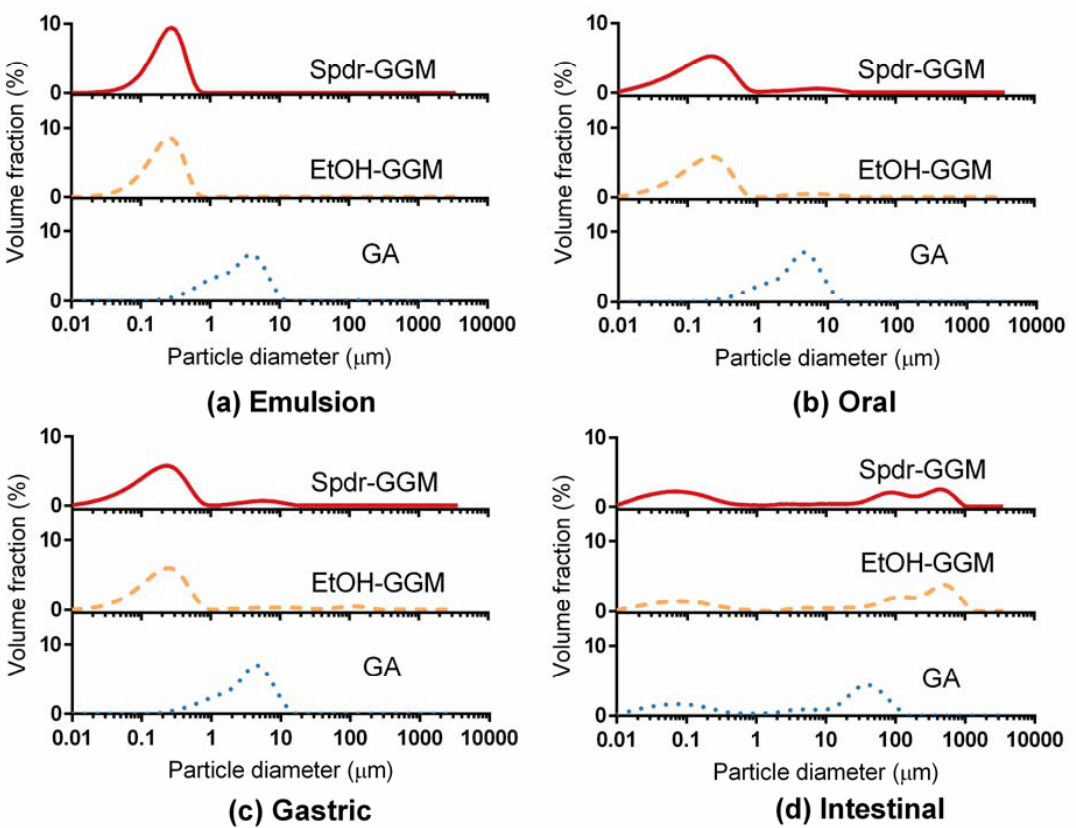
Figure 1. Droplet size distributions of Spdr-GGM-, EtOH-GGM-, and GA-stabilized emulsions before and after in vitro digestion: ( a ) Emulsion, ( b ) Oral phase, ( c ) Gastric phase, and ( d ) Intestinal phase.